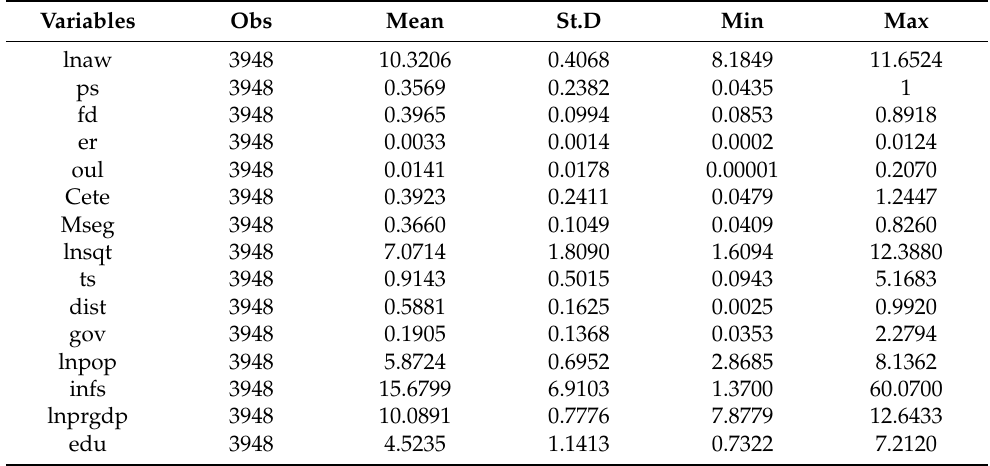
Table 2. Descriptive